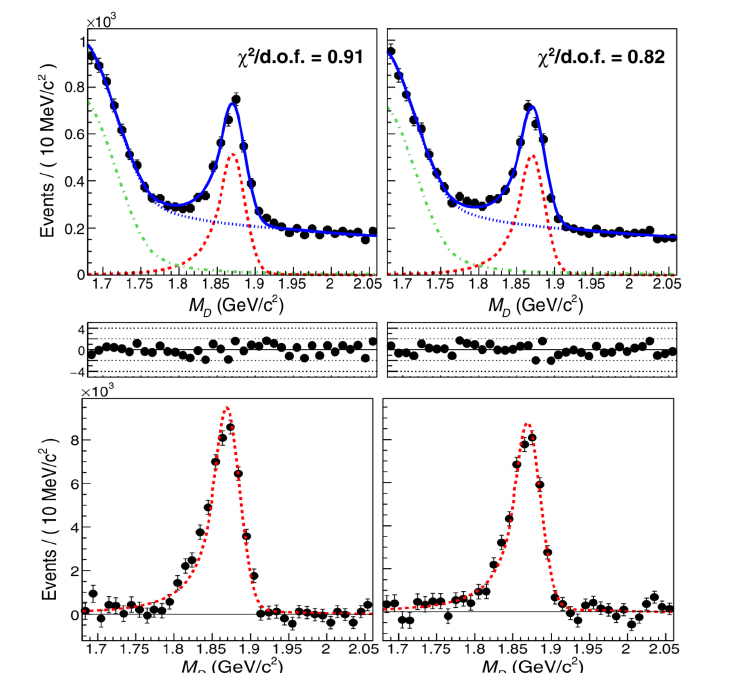
Figure 4. Distributions of invariant mass of D ! (cid:25)(cid:25) sample for the tagged (top) and untagged (bottom), left (right) correspond to D + ( D (cid:0) )